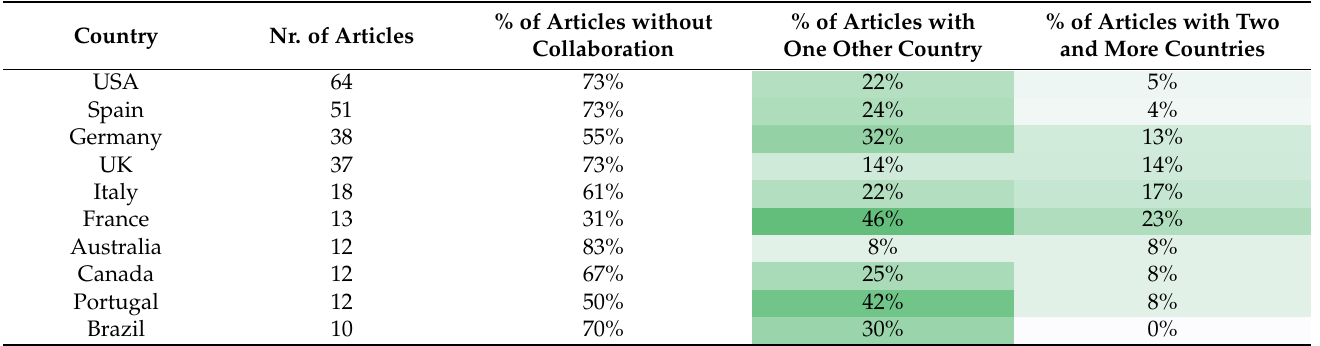
Table 9. Top countries that are involved in at least 10 articles in Publications , and their different shares in co-authored papers with other countries (graduation in green color).